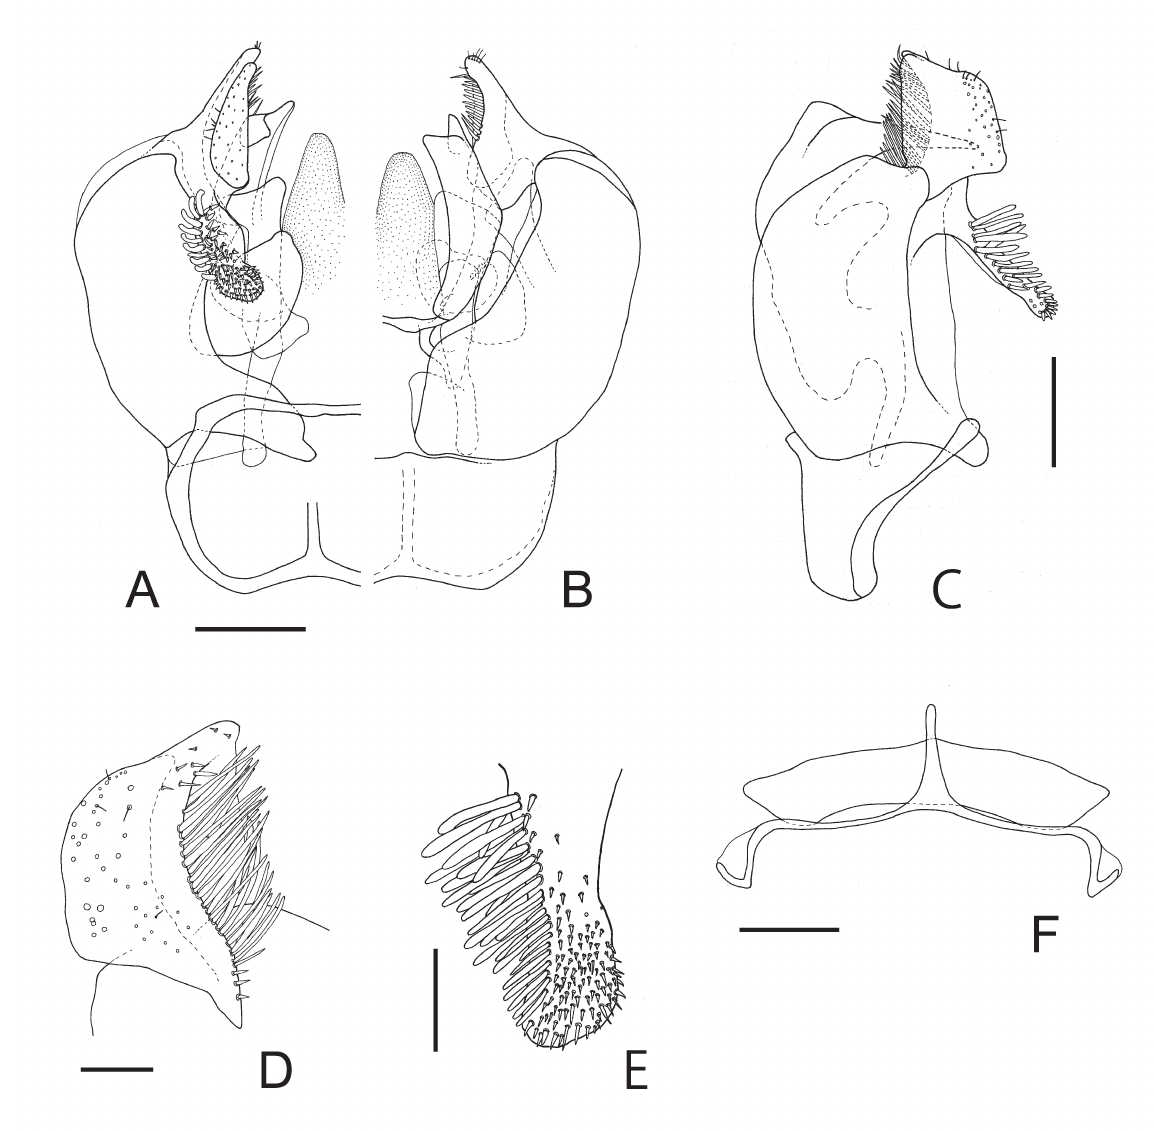
Fig. 16. Lasioglossum ( Dialictus ) problematicum (Blüthgen, 1923), ♂. A . Genitalia in ventral view. B . Genitalia in dorsal view. C . Genitalia in lateral view. D . Gonostylus in inner-lateral view. E . Ventral retrorse lobe of genitalia. F . S7–S8. Scale bars: a–c, F = 0.2 mm, d–e =